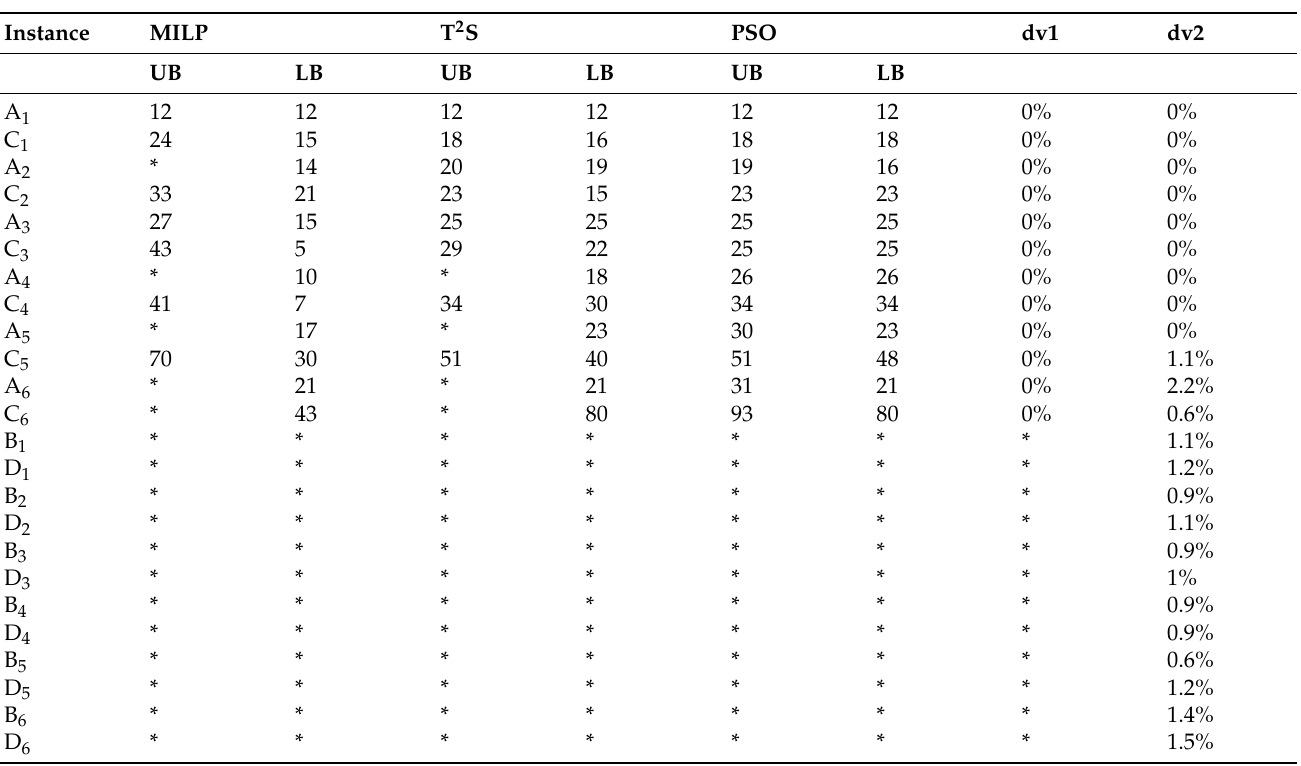
Table 4. Comparison of PSO to